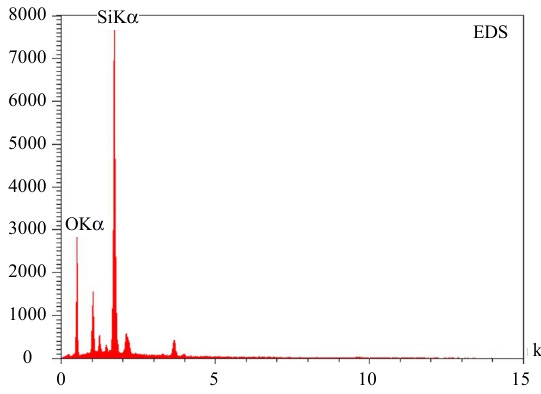
Fig. 5 EDS result of the nanostructured SiO 2 film prepared in this